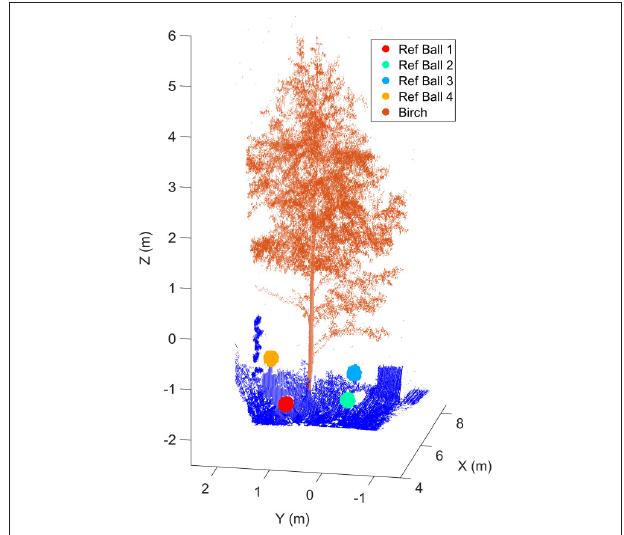
FIGURE 1 | The birch and reference markers at the Finnish measurement site. Reference markers were used in monitoring the HSL ranging stability. Reference target sizes in the figure have been emphasized for visualization purposes. The scanner was located in the origin (0,0,0).